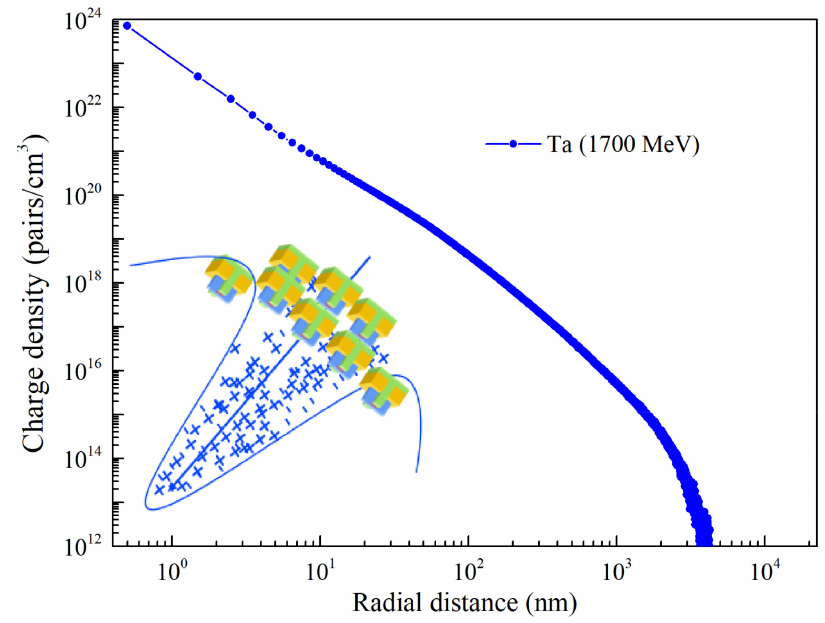
Figure 9. The concentration of electron-hole pairs in device generated by the ionization of 181 Ta ions vs. the radial